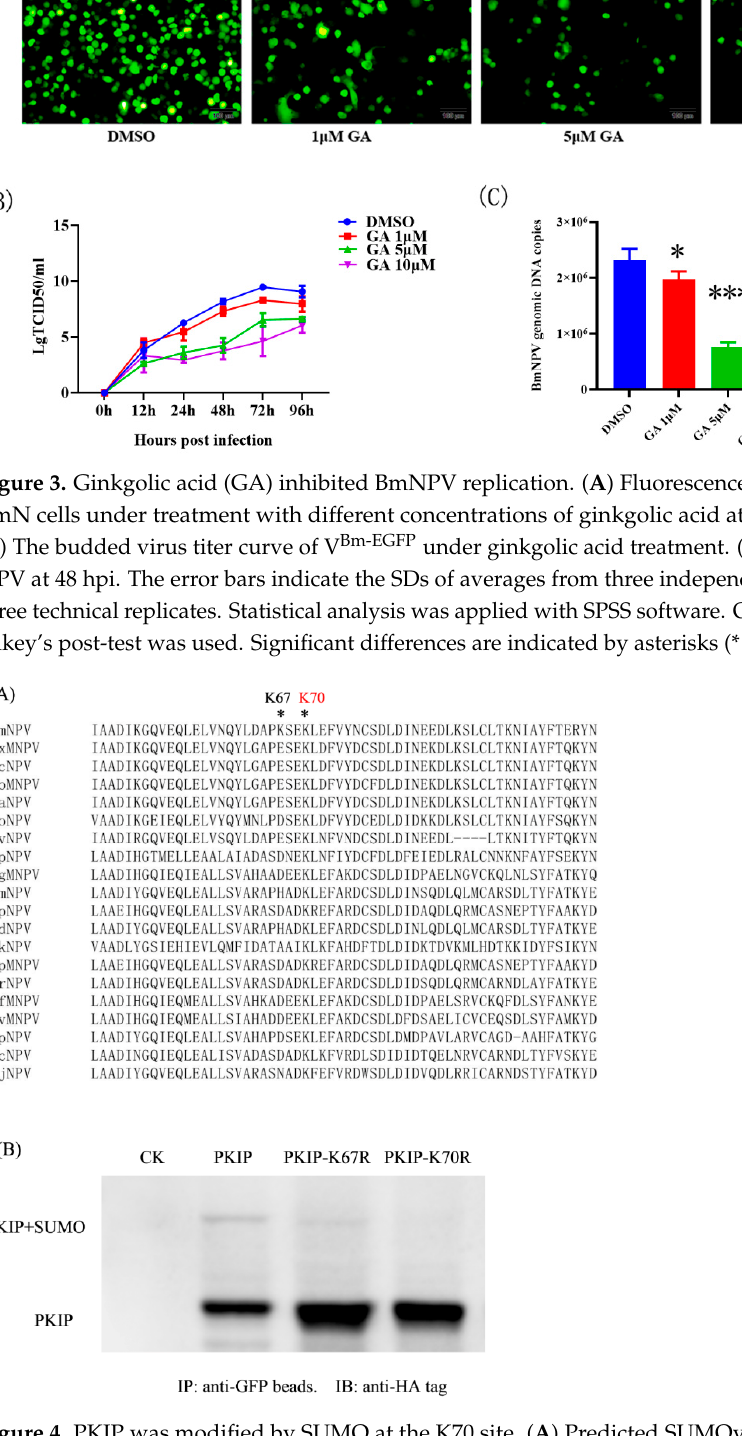
Figure 4. PKIP was modified by SUMO at the K70 site. ( A ) Predicted SUMOylation site in the PKIP of group I baculovirus. ( B ) BmN cells were co-transfected with GFP-SUMO and wild-type HA-PKIP or mutant HA-PKIP (K67R and K70R). Protein extracts of transfected cells were immunoprecipitated using anti-GFP beads. Immunoprecipitated proteins were analyzed using anti-HA antibody.